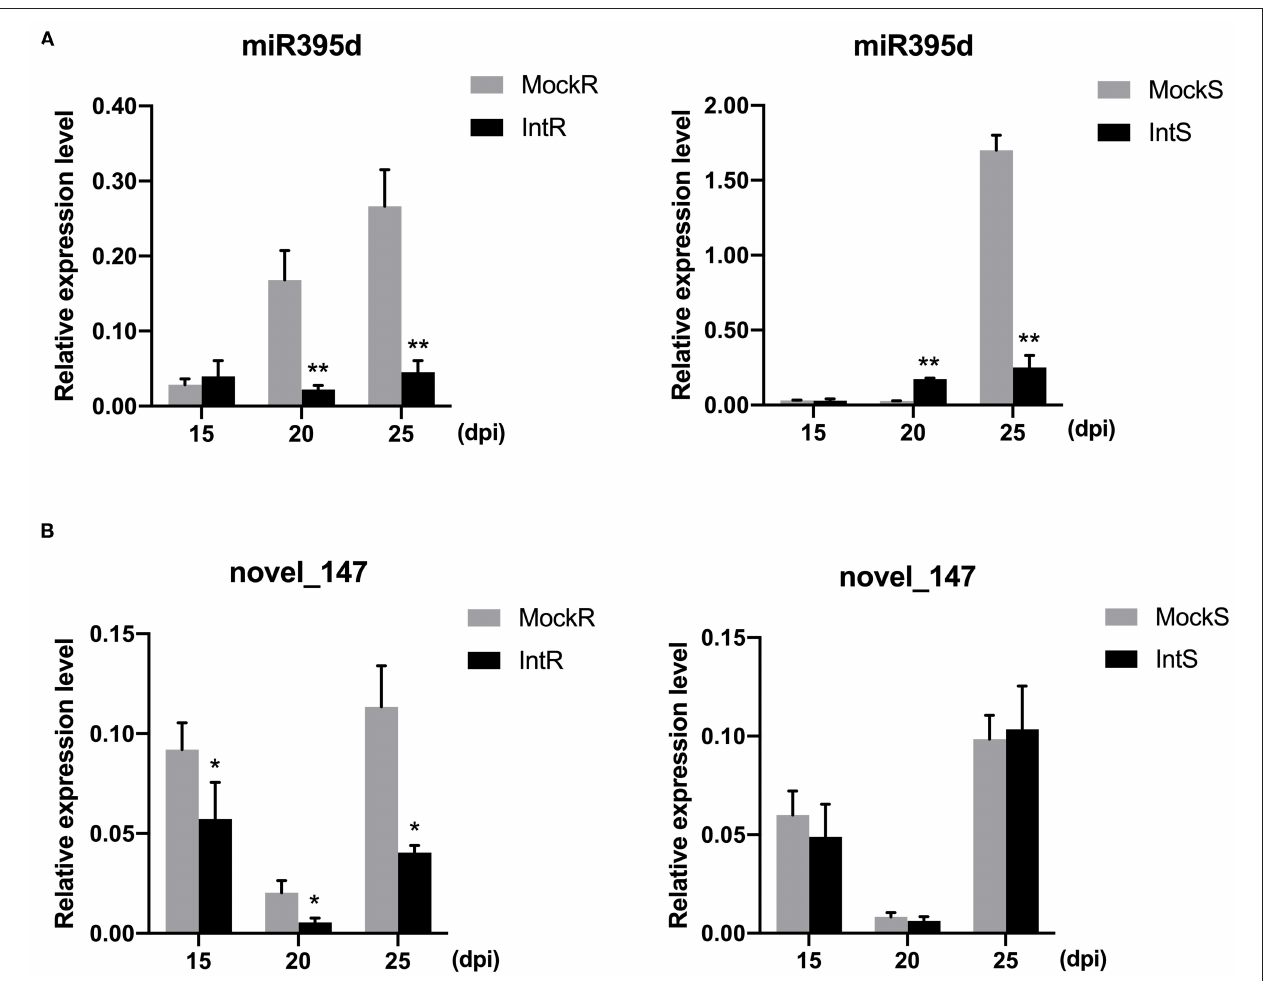
FIGURE 2 | Validation of the relative expression level of (A) miRNA395d and (B) novel_147 in 409R and 409S in response to P. brassicae infection. Y-axis, relative expression level; X-axis, days post-inoculation (dpi). Data were obtained from at least three biological replicates. Bars represent SD (STDEV). * p ≤ 0.05, ** p ≤ 0.01 by Student’s t -test. MockR, 409R without inoculation; IntR, 409R with inoculation; MockS, 409S, without inoculation; IntS, 409S with